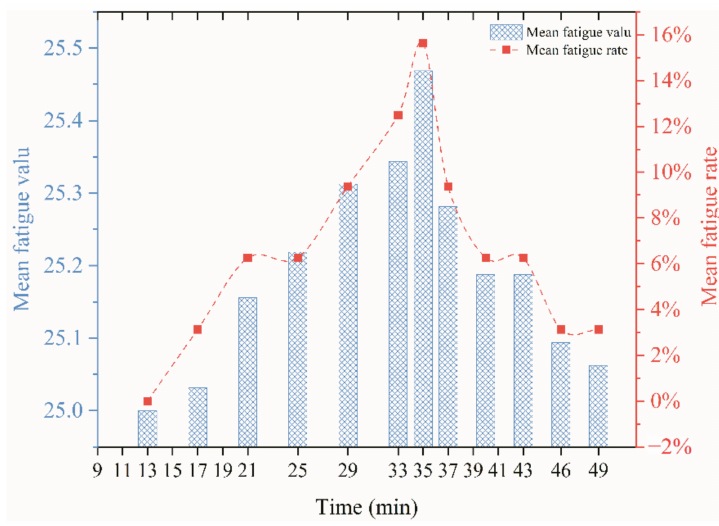
Figure 8. The biaxial plot of mean fatigue value and fatigue